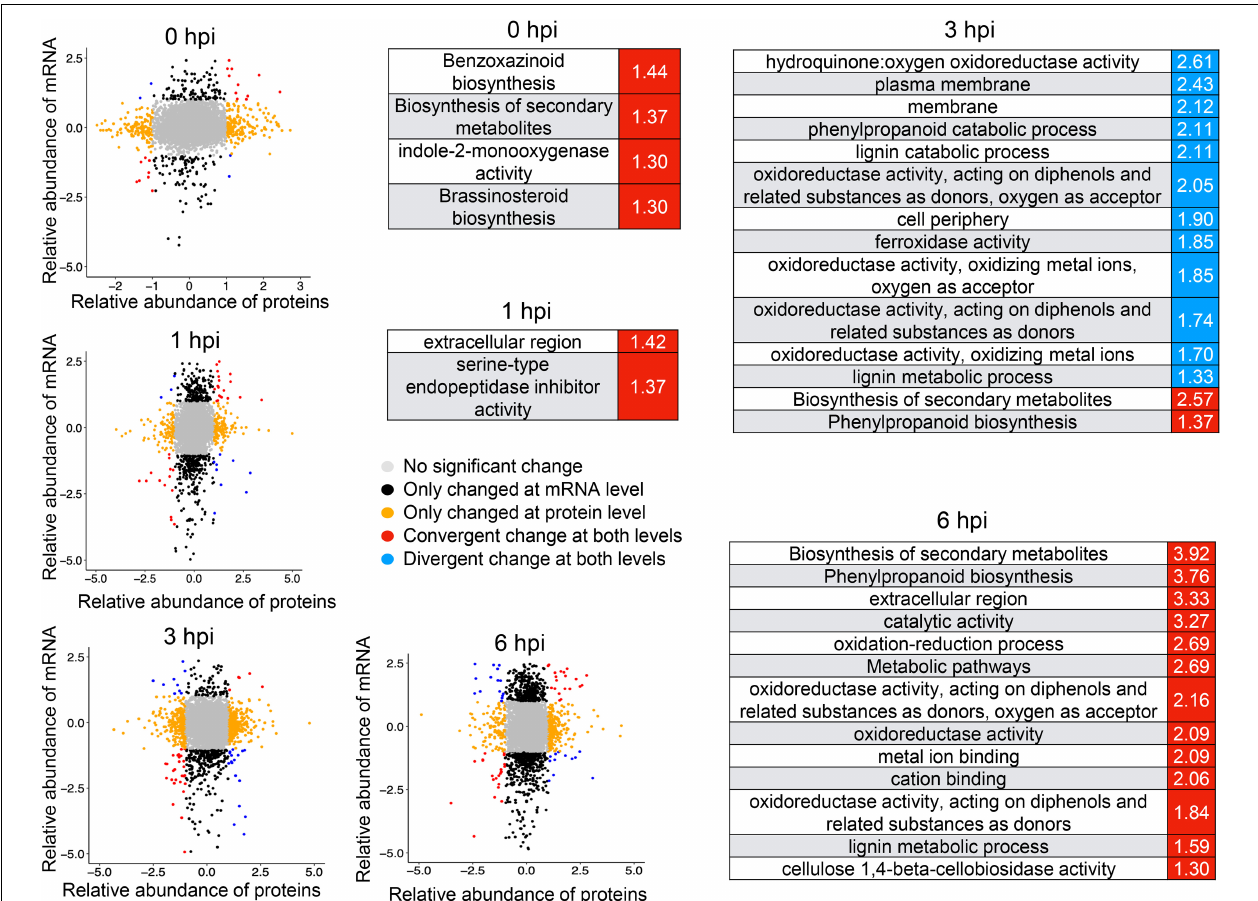
FIGURE 7 | Integrative analysis of RNA-seq and proteomics identified a number of genes co-induced upon resistance to stalk rot disease. The mRNA/protein expression fold changes of samples were calculated by comparing Y331- (cid:49) TE and Y331 at four time points. mRNAs/proteins differentially expressed (| log2[FC]| > 1; p -adj < 0.05) in both, either and neither (unchanged) transcriptome and proteome studies were grouped and color-coded. Red and blue represent the Gene Ontology term significantly enriched by co-induced or co-repressed genes at transcriptional and translational levels,